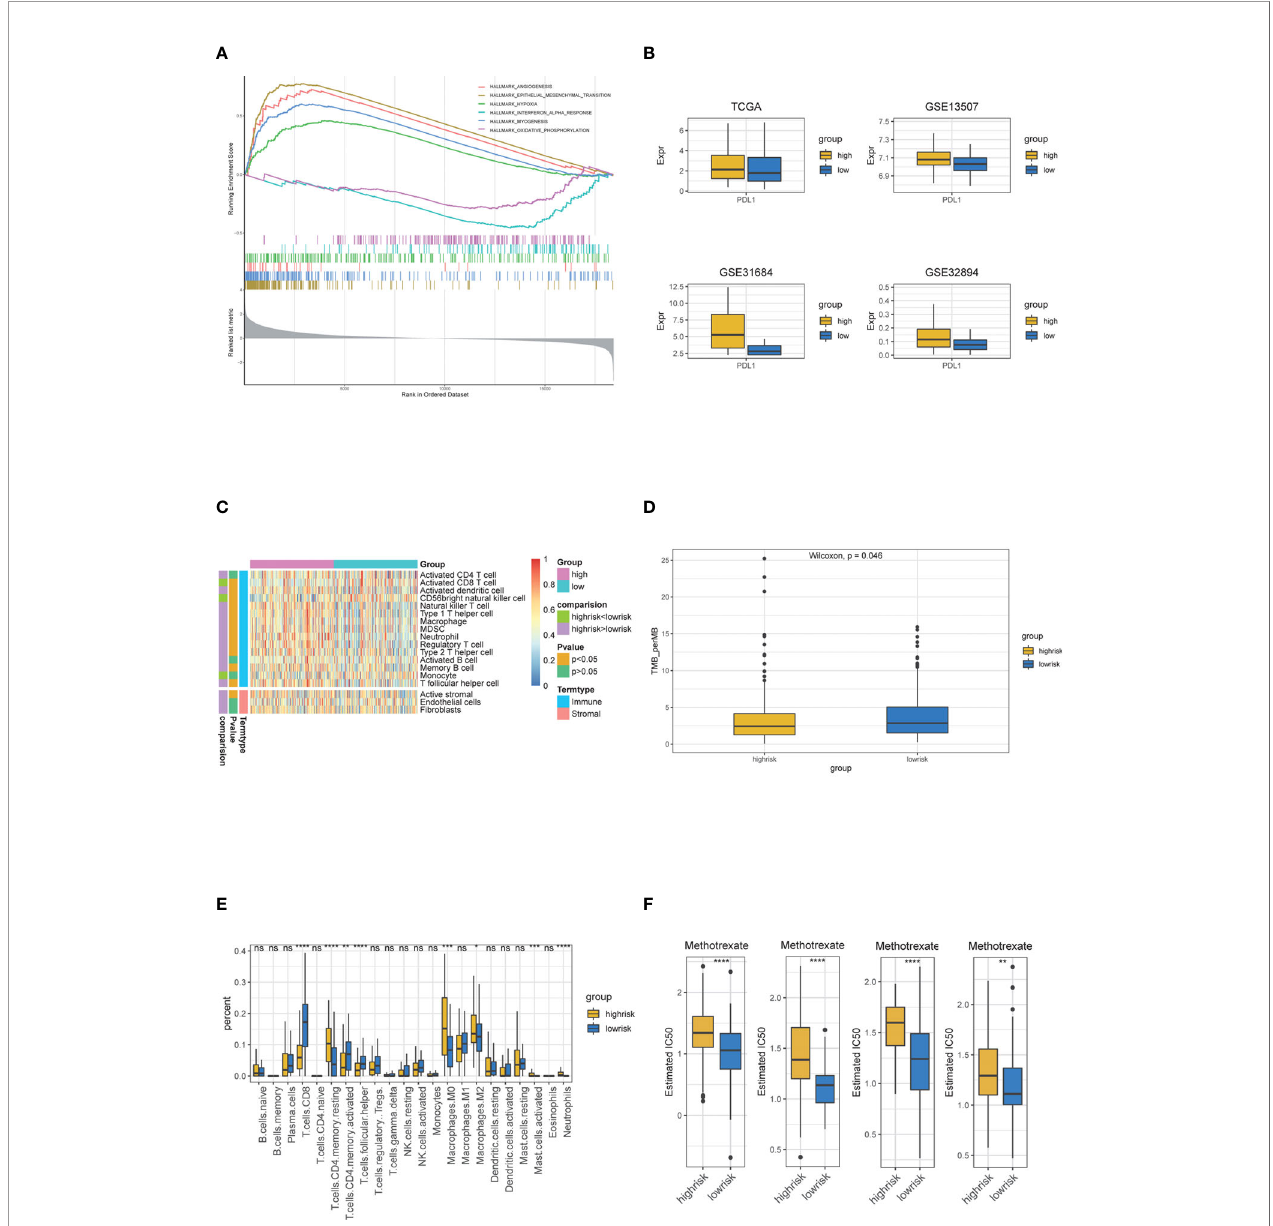
FIGURE 8 | The relationship of fi ve-gene risk groups with functional annotations, TME landscape, immune cell fractions, tumor mutation burden, PDL1 expression and chemotherapy response. (A) The Hallmark enrichment of high- and low-risk groups by GSEA method. (B) Landscape of immune and stromal microenvironment based on immune and stromal signature. (C) Boxplot of the distribution of 22 immune cells in the high- and low-risk groups. (D) PDL1 expression differences. (E) Tumor mutation burden difference. (F) Estimated IC50 indicates the ef fi ciency of chemotherapy to high- and low-risk groups by